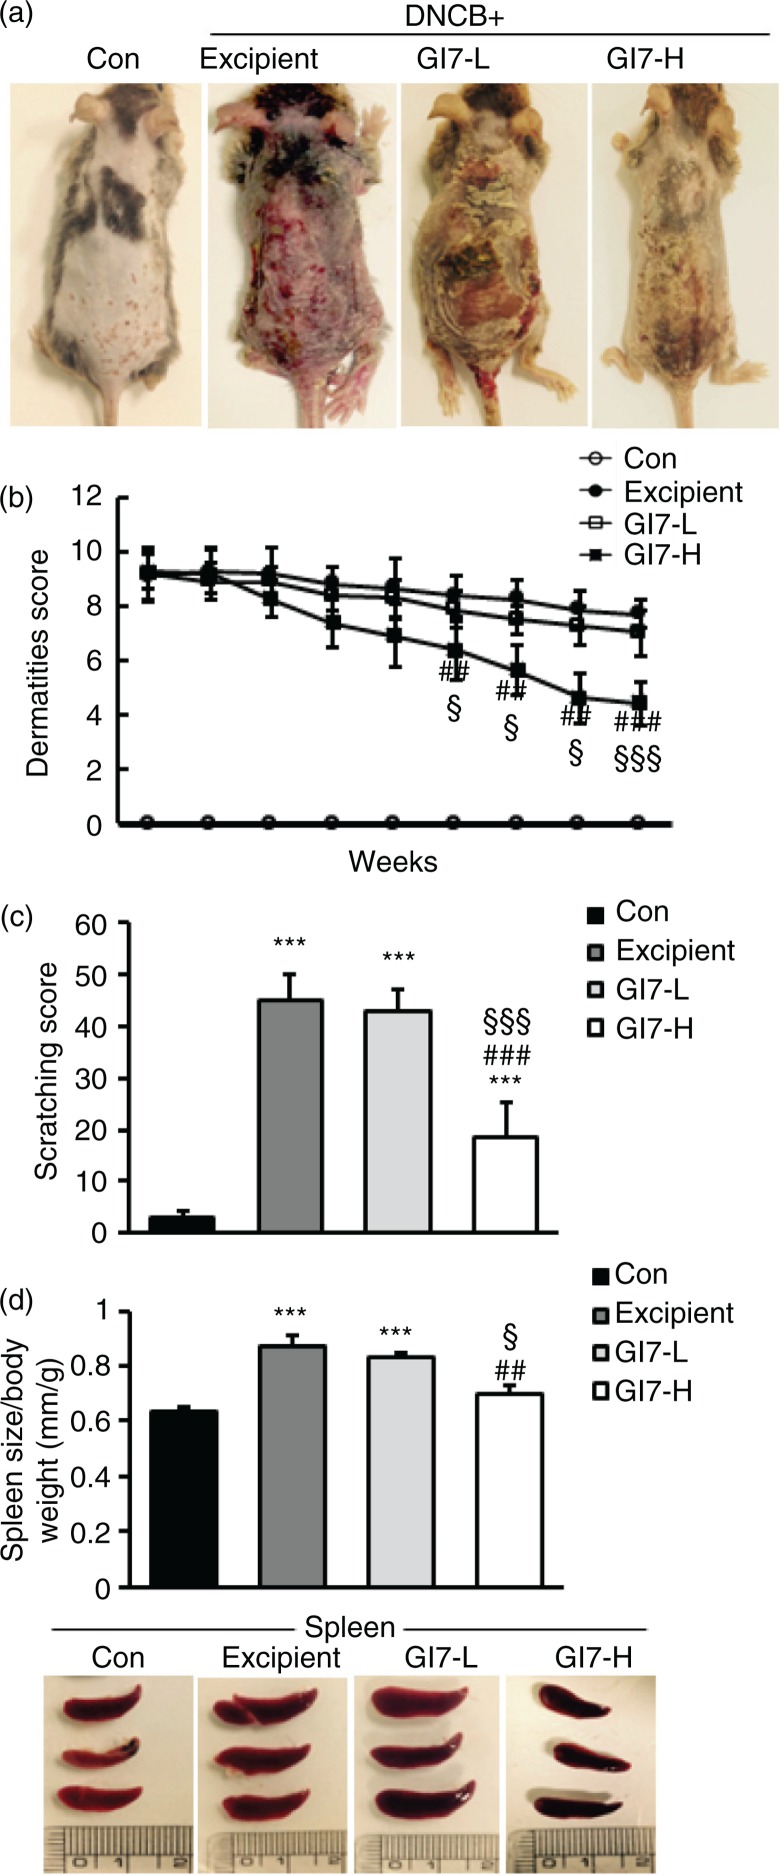
Effect of GI7 on DNCB-induced AD-like symptoms in NC/Nga mice. (a) DNCB-induced AD-like skin lesions in NC/Nga mice. (b) The dermatitis score of AD-like skin lesions was measured concerning itching, erythema/hemorrhage, scaling/dryness, edema, and excoriation/erosion every week. (c) Scratching behavior of the mice was observed for 10 min after sensitization. (d) After sacrifice, the spleen was isolated and photographed to examine morphological alteration. Spleen size-to-body weight ratio was evaluated. Results are expressed as the means±SD (n=12). ***p<0.001 versus the control group; ##
p<0.01, ###
p<0.001 versus the excipient group; §
p<0.05, §§§
p<0.001 versus the GI7-L group.